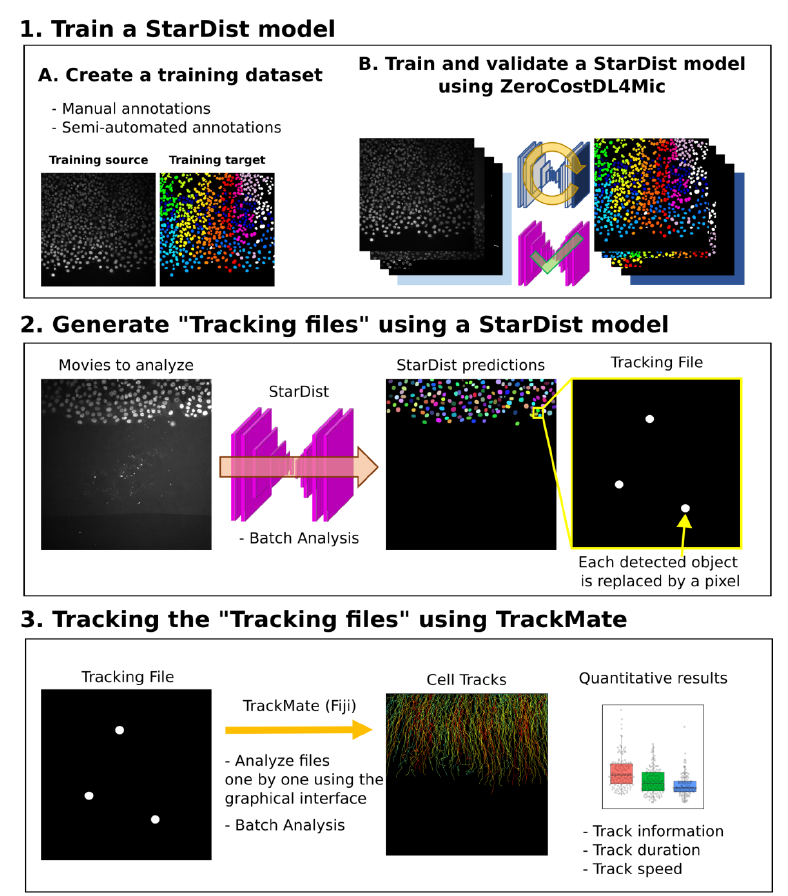
Figure 1. Workflow depicting how StarDist and TrackMate can be combined to track cells